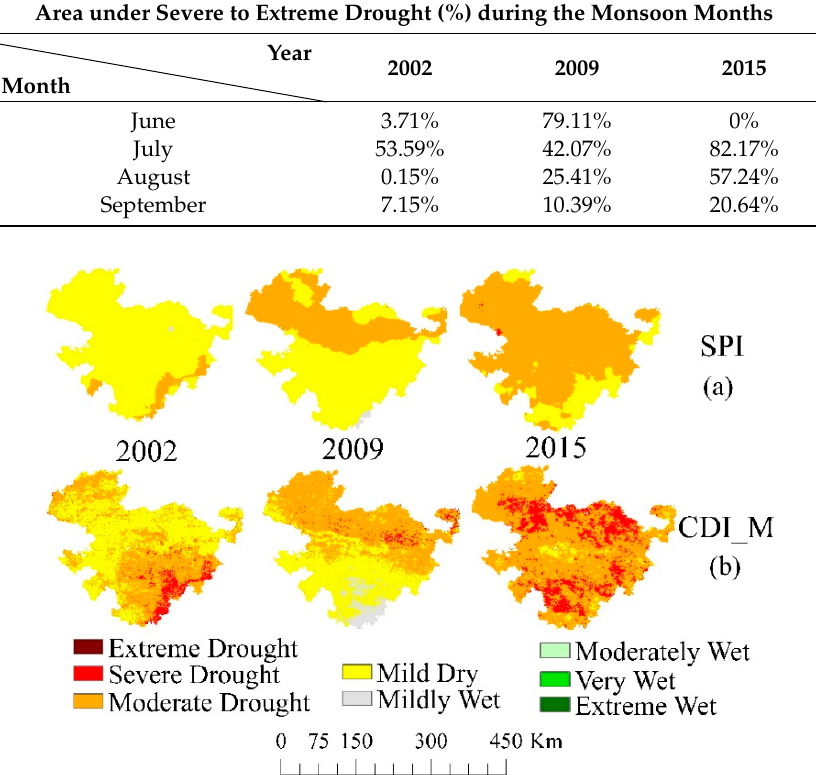
Figure 7. Comparative analysis of pure standardized precipitation index (SPI) vs. combined drought indicator for Marathwada (CDI_M) based drought maps for 2002, 2009, and 2015. The maps in the top row show pure SPI ( a ) whereas the bottow row show CDI_M where SPI contributed 40% ( b